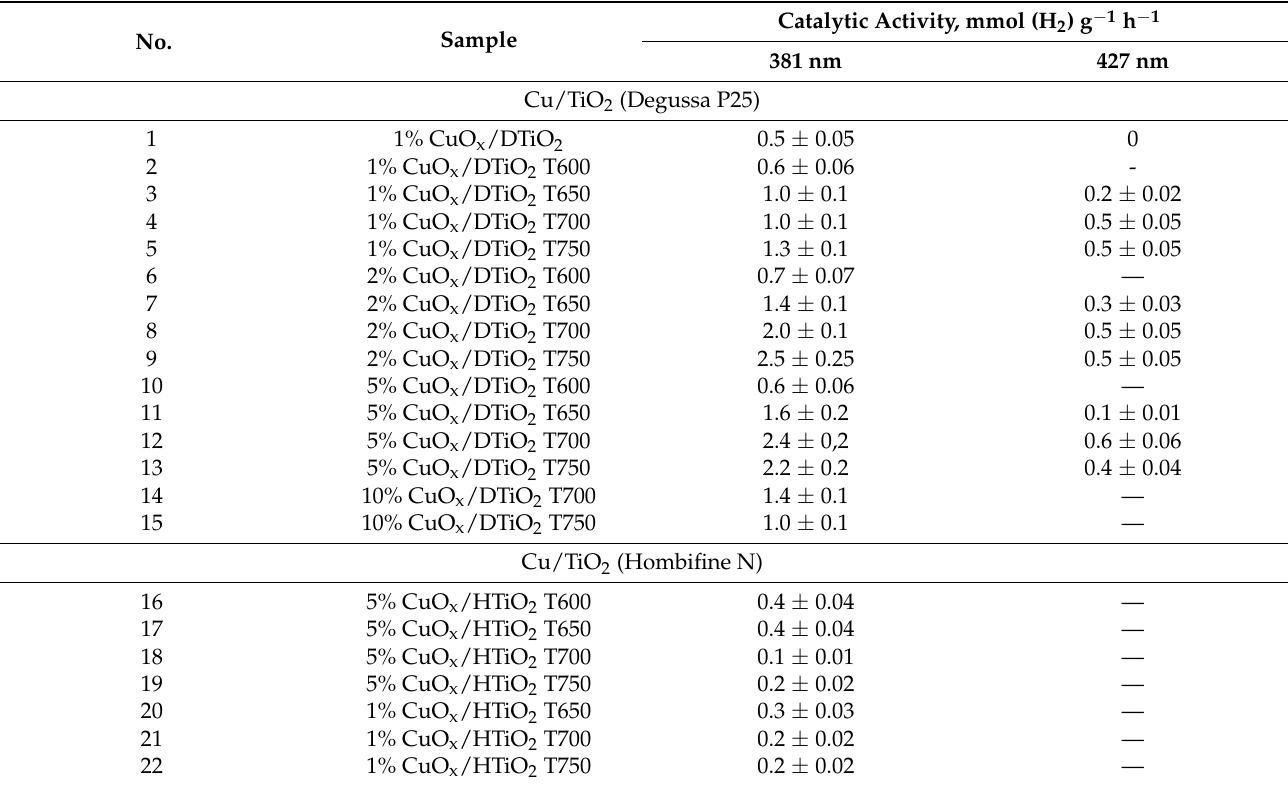
Table 5. Activity of synthesized photocatalysts.